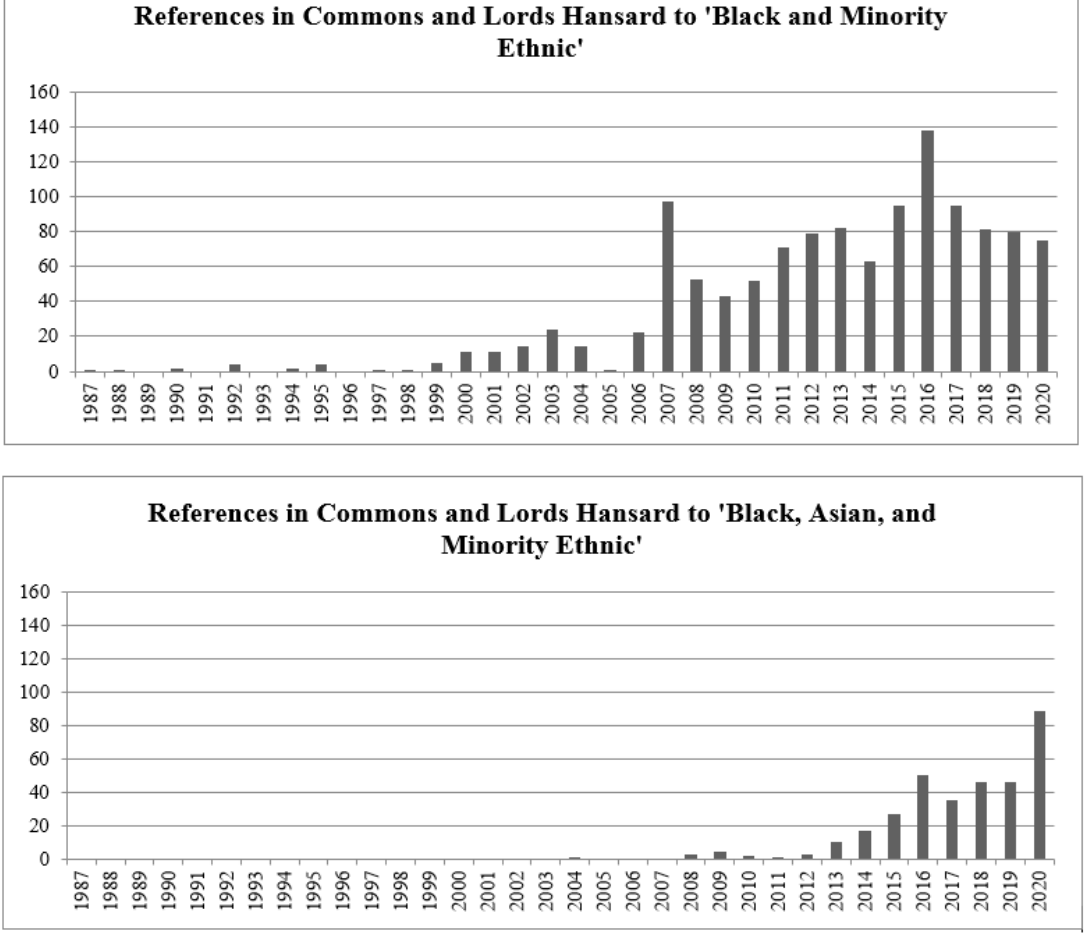
Figure 1. References in UK Parliament Hansard to ‘Black and Minority Ethnic’ (BME) and ‘Black, Asian, and Minority Ethnic’ (BAME). Note: 2020 data is for January–June only.